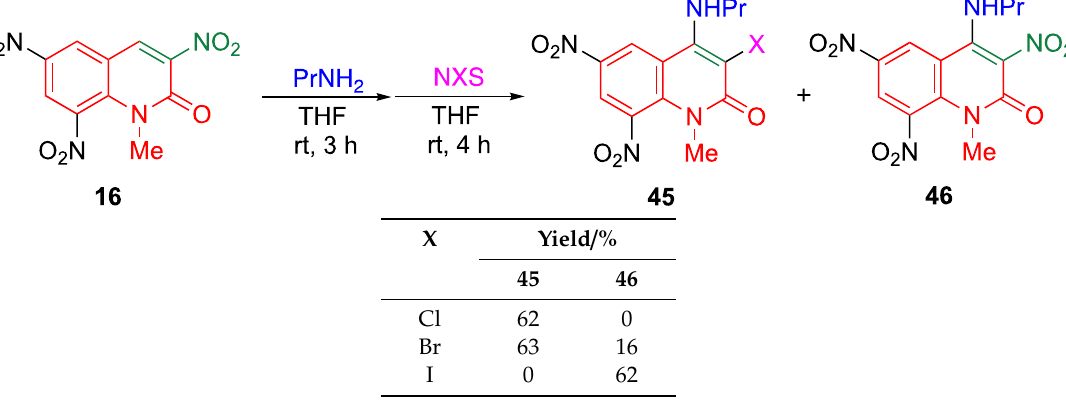
Table 15. Scanning of halogenating agents.